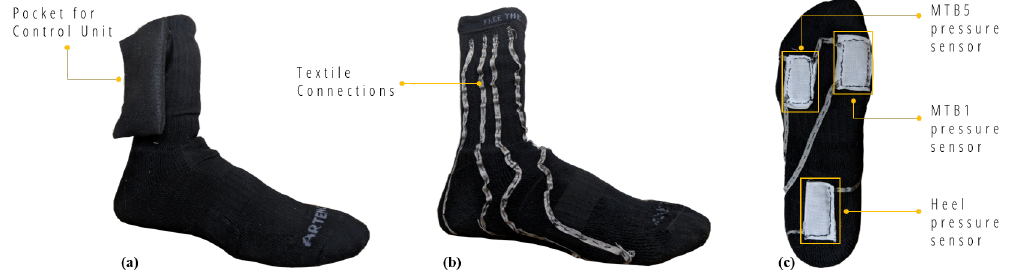
Figure 2. SWEET Sock sensing unit: ( a ) external view; ( b ) internal view of textile connections; ( c ) textile pressure